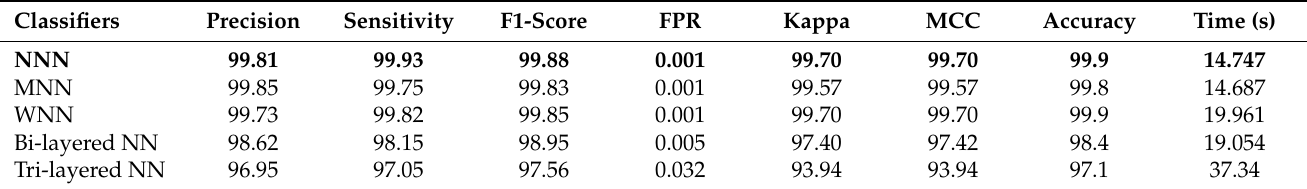
Figure 10. Proposed fusion method confusion matrix of WNN on COVID-19 Lung CT Scans dataset. Table 8. Proposed ITCO optimization results on COVID-19 Lung CT Scans